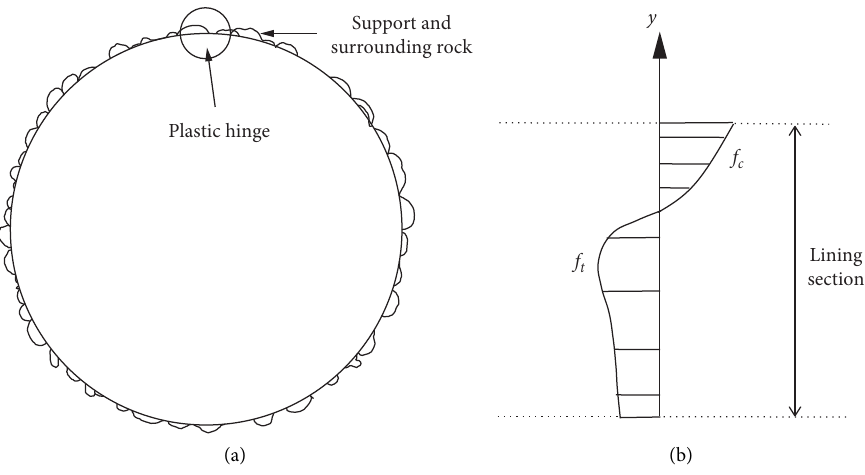
Figure 17: Stress distribution of cracked section of lining. (a) Plastic hinge. (b) Tensile stress